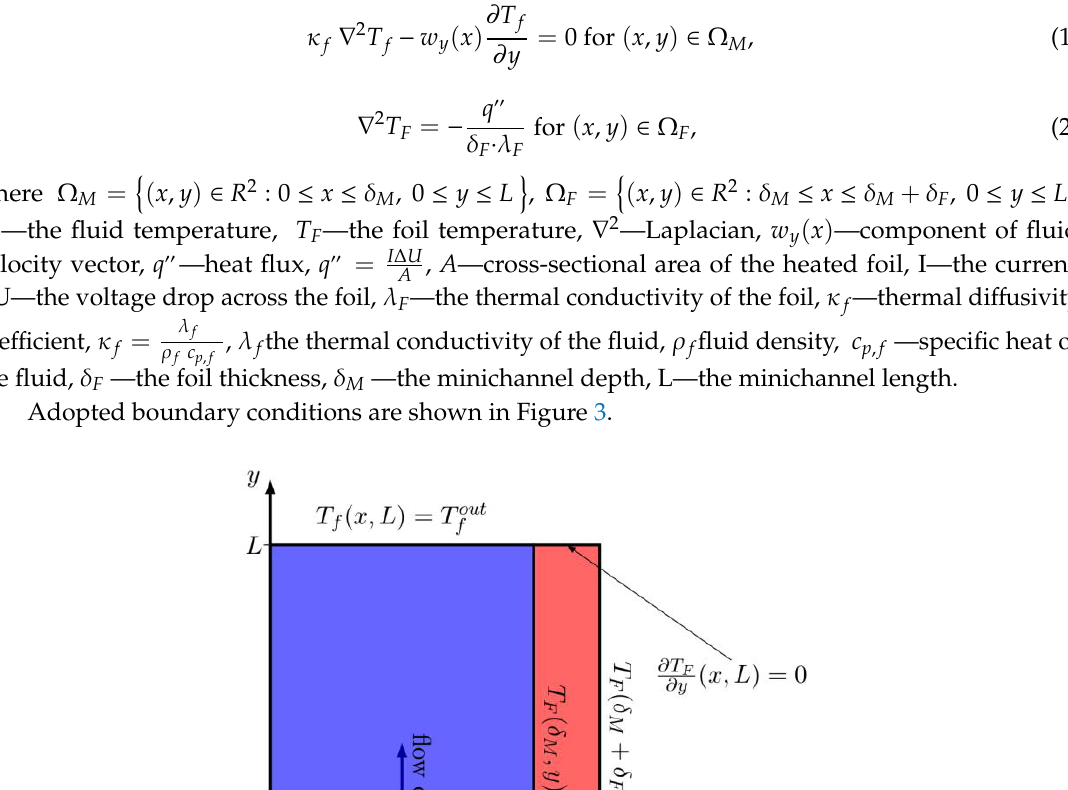
—the fluid temperature at the minichannel inlet, f